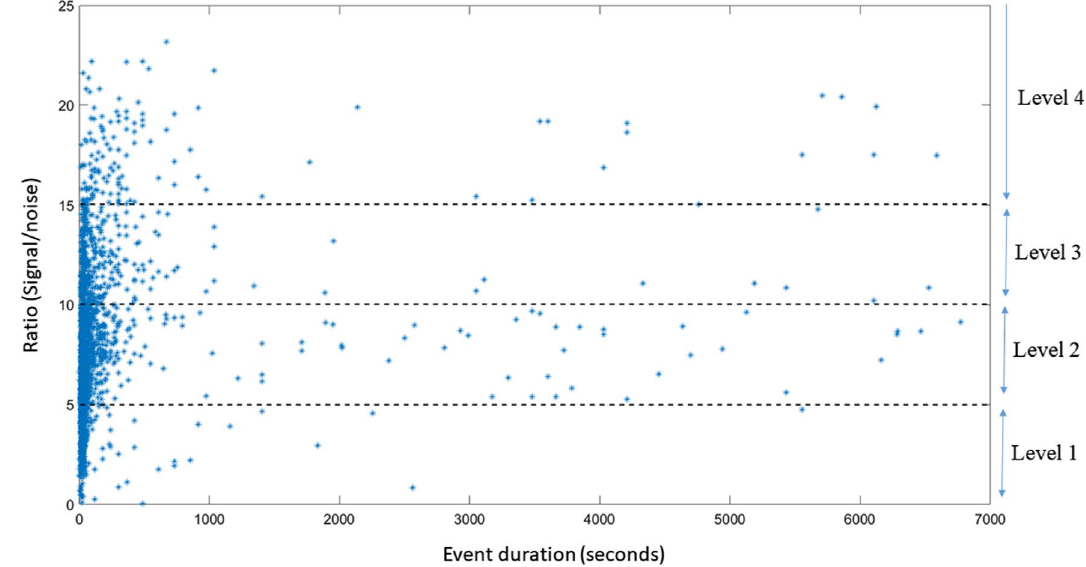
Fig. 17. Presentation of the data-set detected manually to label solar events of June 2012 and June